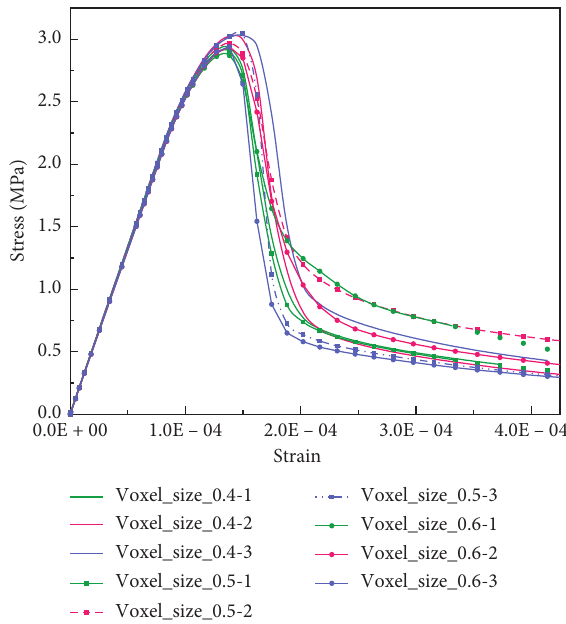
Figure 4: Stress-strain curves of different mesh size